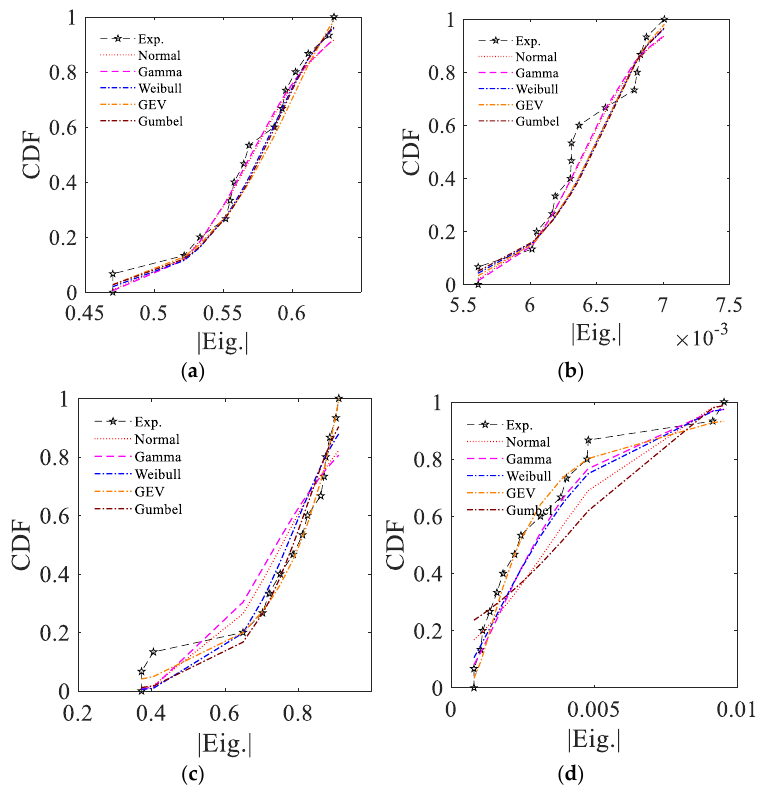
Figure 8. Cumulative density function (CDF) of Mode #1 and z/H = 1 of the eigenvector with U = 49.0 along wind ( a ) and across wind ( b ) and 111.8 m/s along wind ( c ) and across wind ( d ).